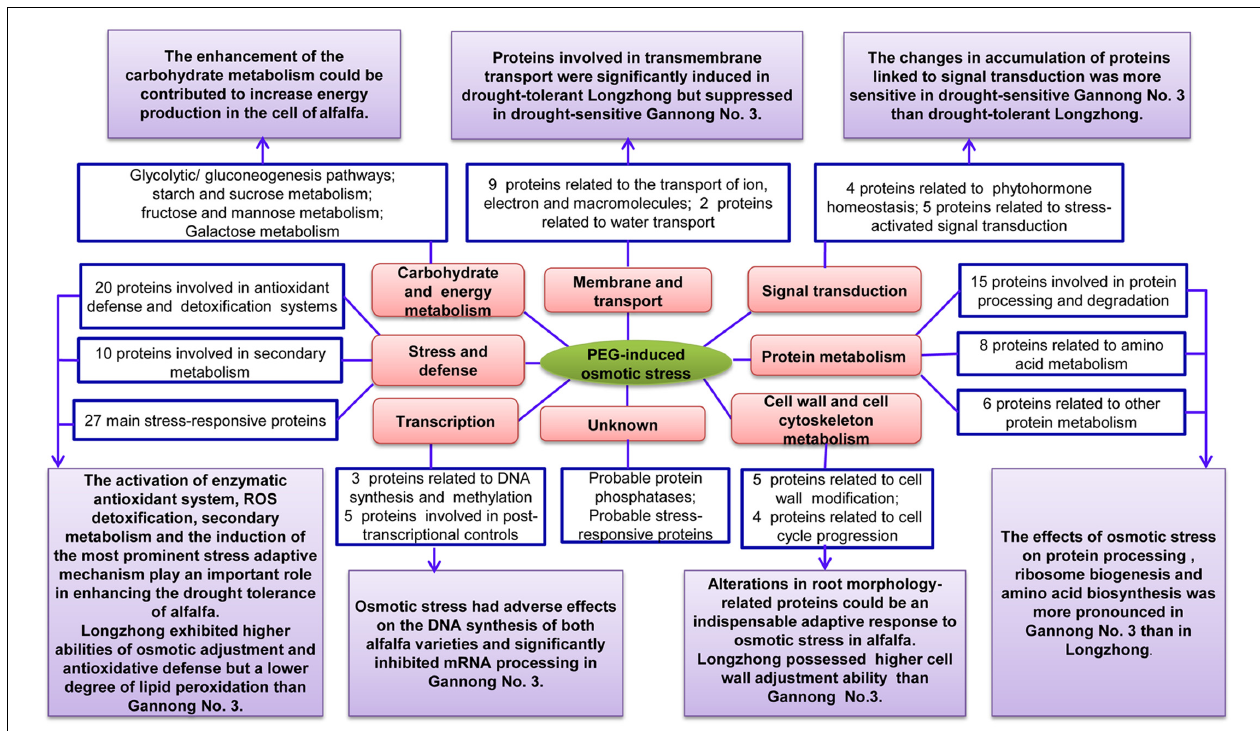
FIGURE 8 | Model shows the differential responses of two alfalfa varieties with contrasting drought tolerance to PEG-induced osmotic stress based on physiological and proteomic changes.